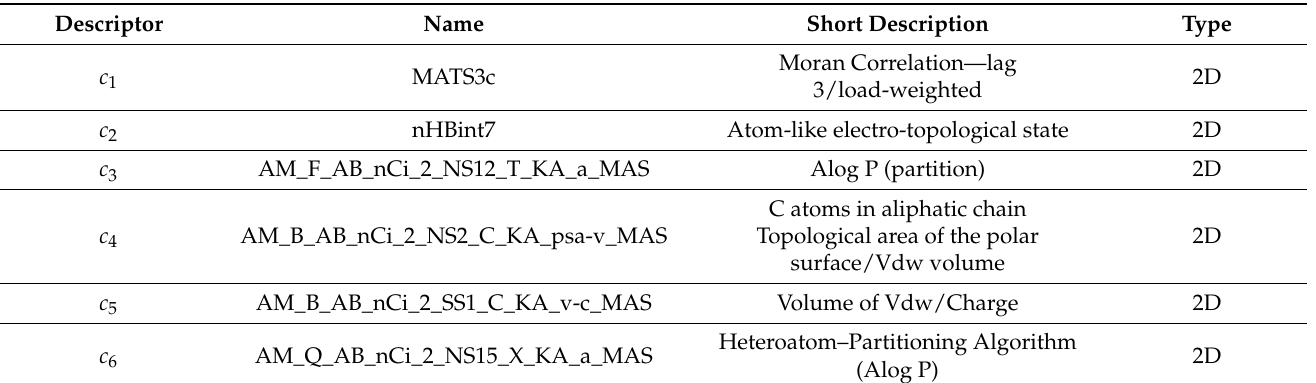
Table 3. Molecular descriptors in the anti- L. infantum QSAR model, as described by Equation